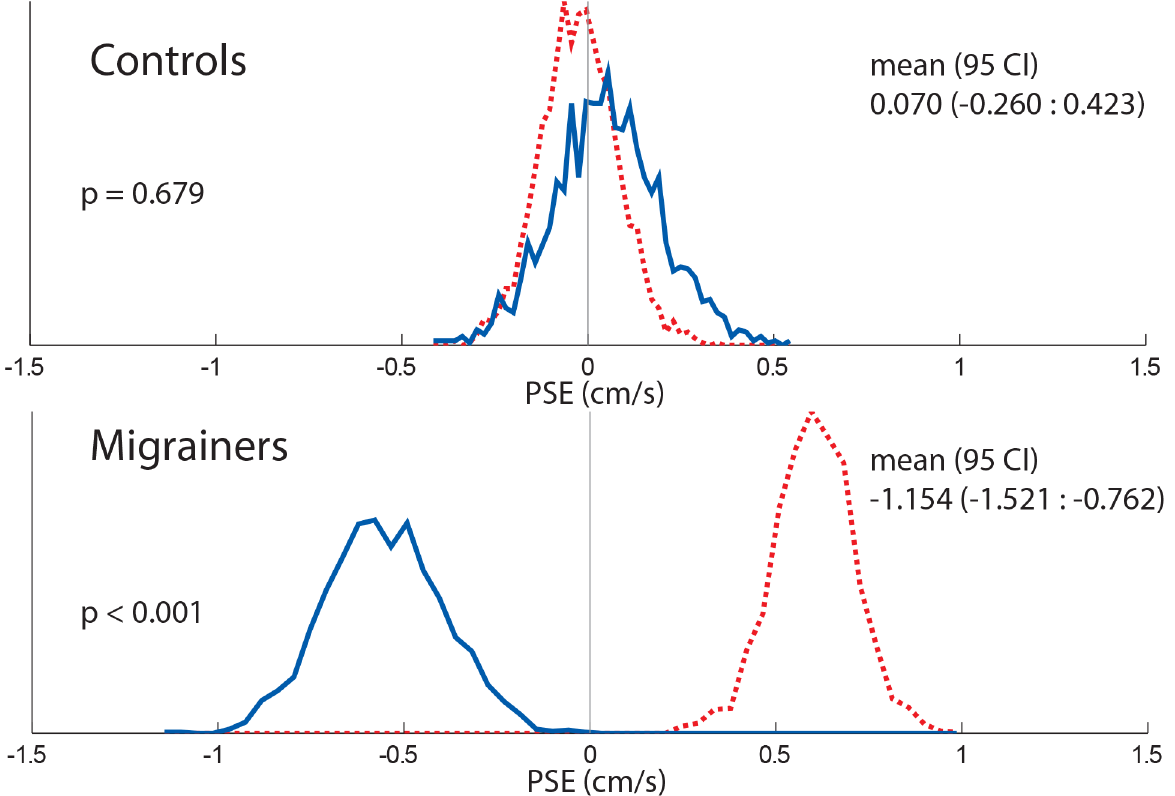
Fig 15. 16s Histogram comparing combined controls and migrainers response using a random resampling of responses. Responses from all subjects were included. Responses collected with looming VFM are represented with a dashed red line, receding VFM responses are represented with a solid blue